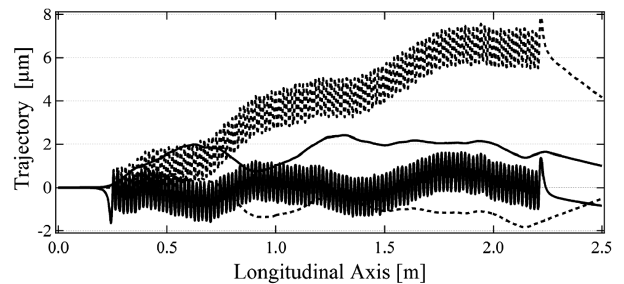
FIG. 7. Electron beam trajectory in the cryogenic undulator at room temperature calculated with B2E code from Hall probe magnetic measurement at SOLEIL ( E ¼ 2 . 75 GeV), with a precision of 0.5 Gauss. (Solid line) Horizontal and vertical trajectories after the assembly and corrections. (Dashed line) Horizontal and vertical trajectories after the assembly and before shimming.